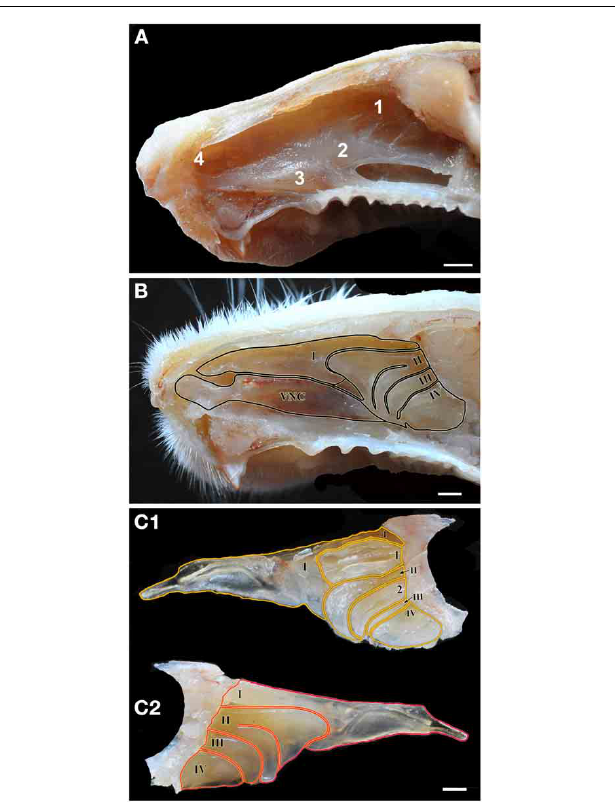
FIGURE 1 | Views of the nasal cavity. (A) The nasal septum, showing the location of the main olfactory epithelium (1), the septal organ (2), the vomeronasal organ (3) and Grüneberg’s ganglion (4). (B) Medial view of the nasal conchae and ethmoturbinates following removal of the nasal septum, with endoturbinates numbered by Roman numerals (VNC, ventral nasal concha). (C) Lateral (C1) and medial (C2) views of the isolated dorsal nasal concha and ethmoturbninates, with ectoturbinates numbered by Arabic numerals and endoturbinates as in (B) . Scale bars: (A) 2mm; (B,C) 1mm.